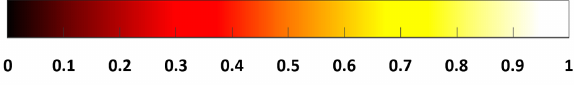
Figure 11. SSIM error map colorbar.